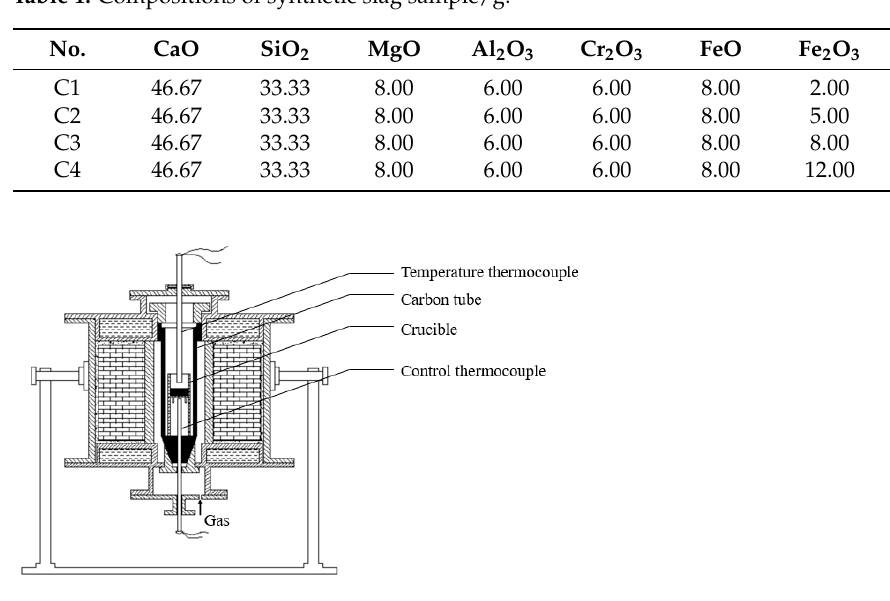
Figure 1. Experimental device diagram. Table 1. Compositions of synthetic slag sample/g.